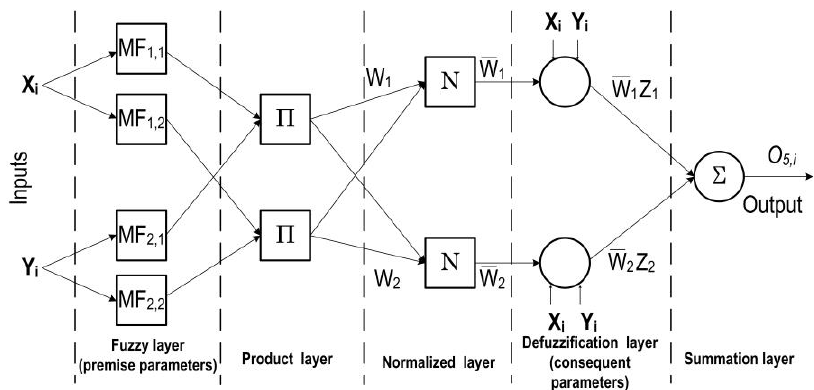
Figure 1. Equivalent adaptive neuro fuzzy inference system (ANFIS) architecture of a two-input ANFIS model with two rules.